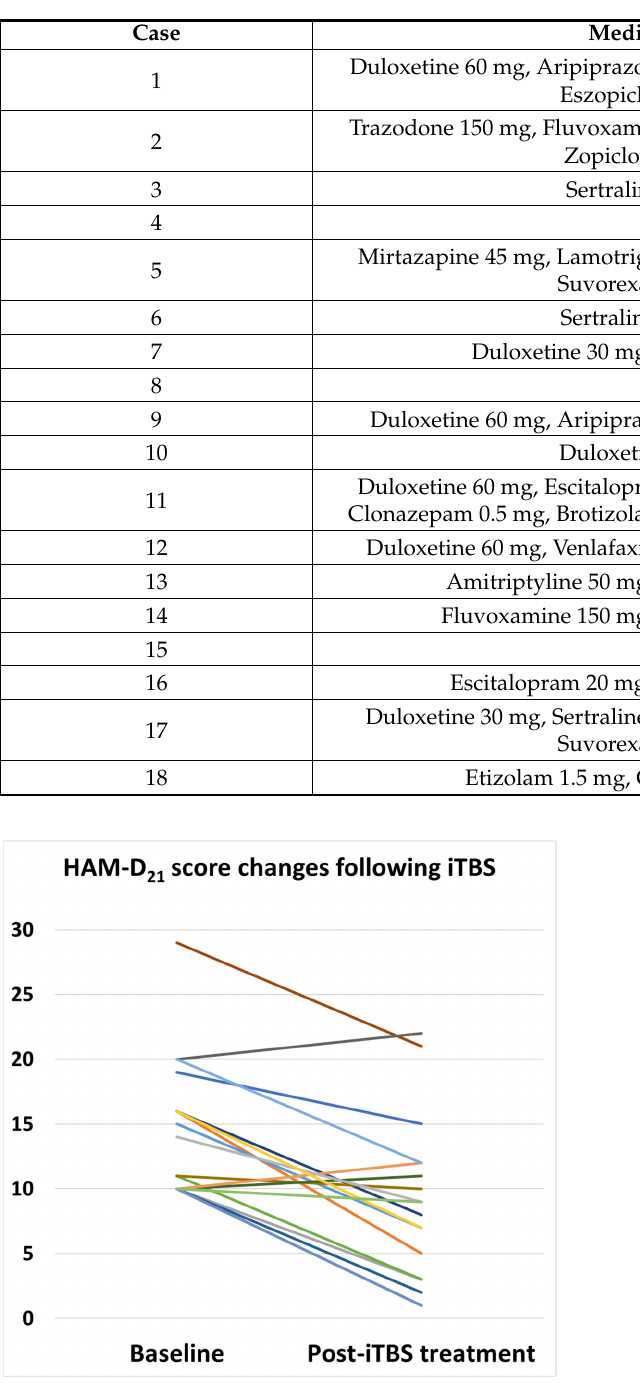
Table 2. Medication information.